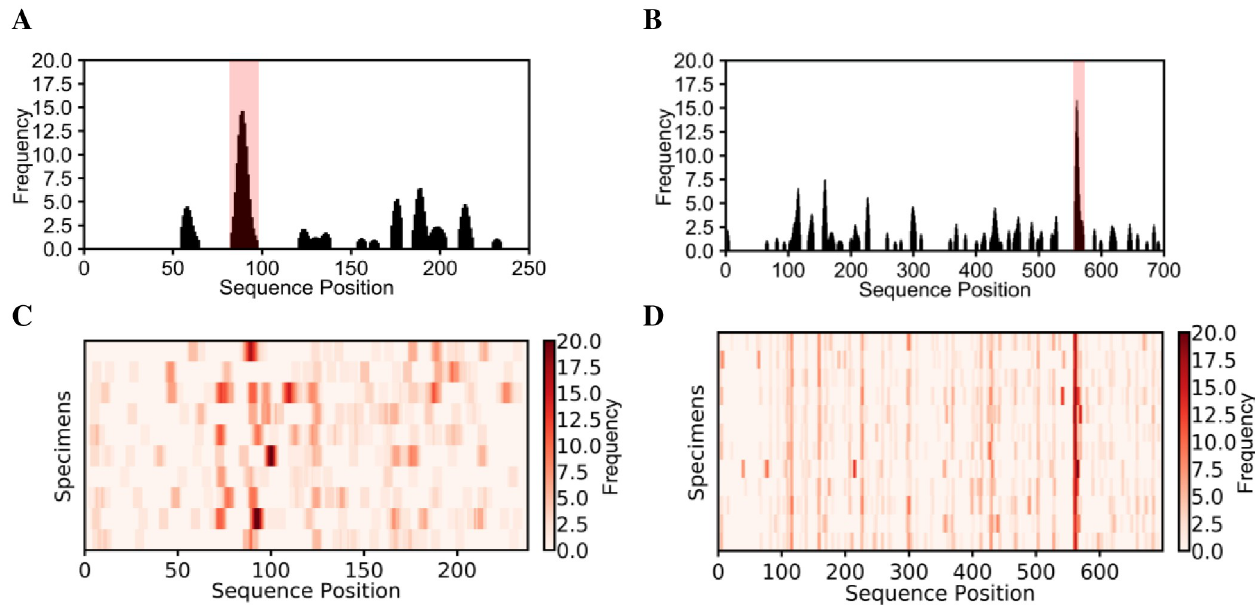
Fig 5. K-TOPE predicted epitopes for glycoprotein G1 using HSV1 specimens and for glycoprotein G2 using HSV2 specimens. For glycoprotein G1, a representative histogram for a single specimen is shown in (A) and a heat map for all HSV1 specimens is shown in (C). For glycoprotein G2, a representative histogram for a single specimen is shown in (B) and a heat map for all HSV2 specimens is shown in (D). There was a single epitope predicted for each protein. Epitopes with percentiles > 97% are highlighted in pink.